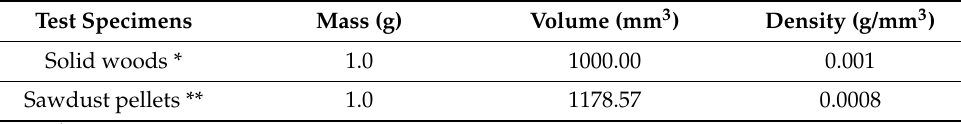
Table 3. Physical characteristics of the solid wood and sawdust pellets of the test